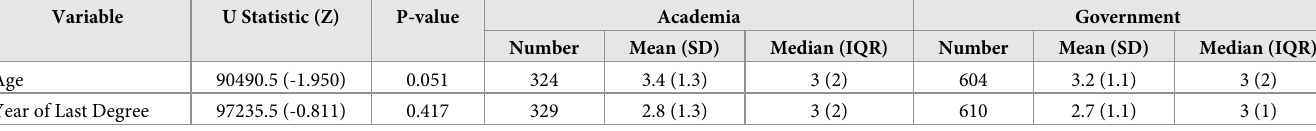
Table 2. Mann-Whitney U tests of ordinal demographic variables. Variable U Statistic (Z)